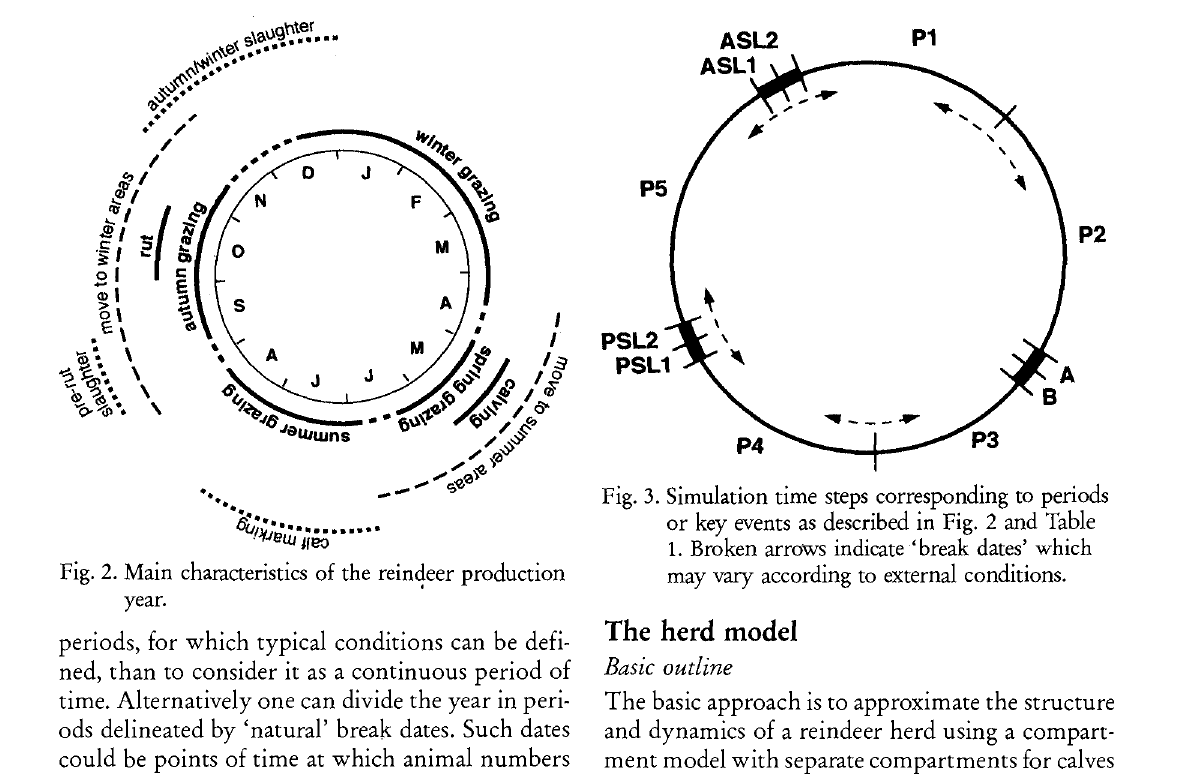
Fig. 2. Main characteristics of the reindeer production year.